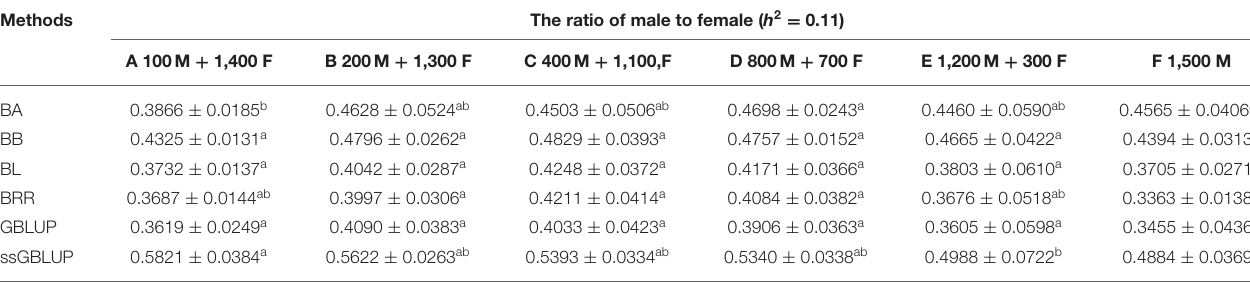
TABLE 10 | Accuracy of GEBV in six levels ratio of male to female with heritability of live body weight under different models. Methods The ratio of male to female ( h 2 = 0.11)